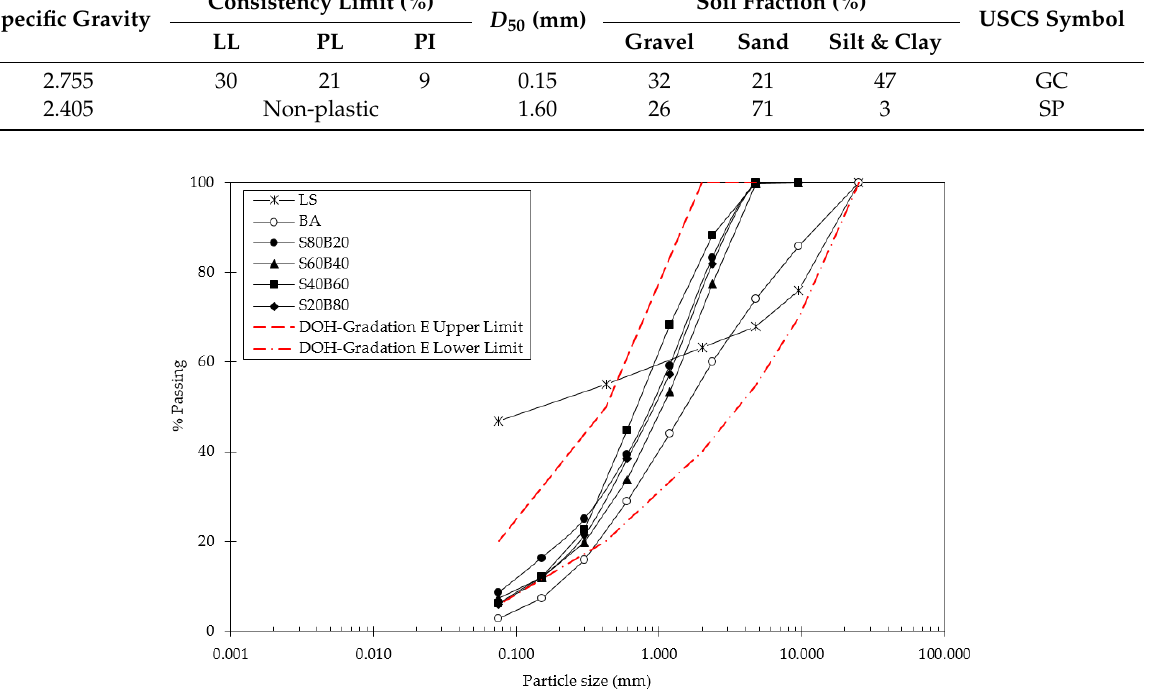
Figure 1. Grain size distribution curves of the LS, BA, and LS+BA. Table 1. Physical properties of the LS and BA.